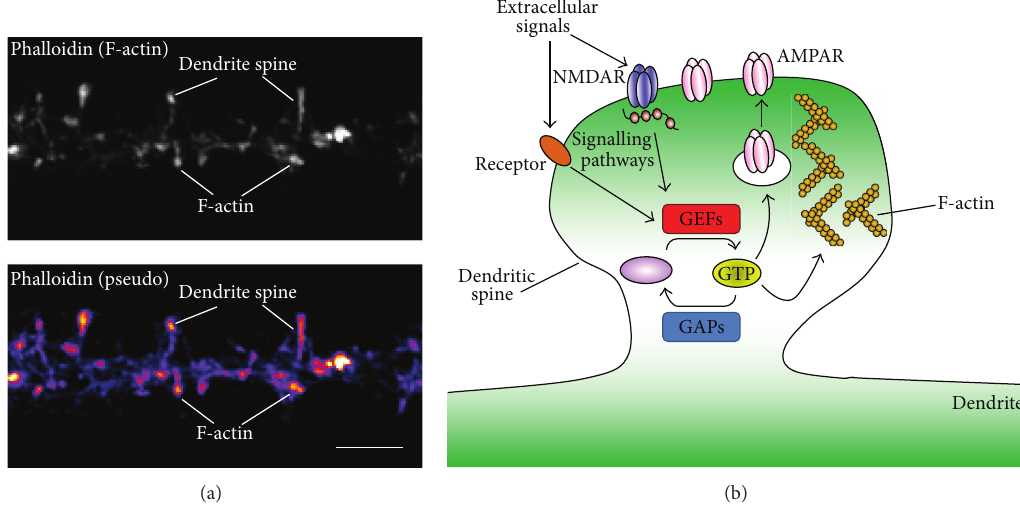
Figure 2: Dendritic spines, small GTPases, and the cytoskeleton. (a) Example of a cortical neuron immunostained with phalloidin, a marker of endogenous F-actin. Immunofluorescence reveals an enrichment of actin in dendrites and dendritic spines. (b) Schematic drawing of how extracellular signals can act via specific receptors and act via small GTPases to regulate actin dynamics and/or receptor trafficking. The dynamic actin cytoskeleton confers much of the structure of the dendritic spines, and alterations in synaptic expression of glutamate receptors (e.g., AMPA receptors) are thought to play a major role in modulating synaptic